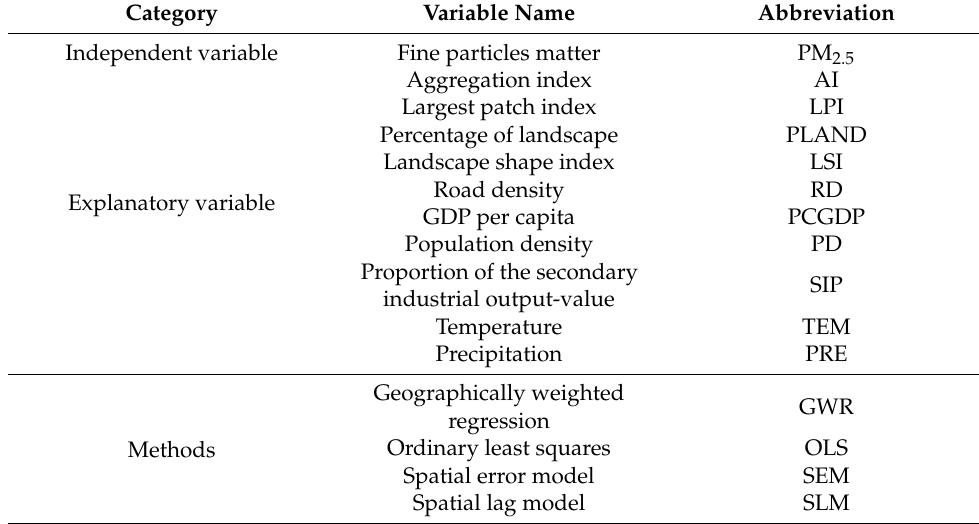
Table 1. Abbreviation